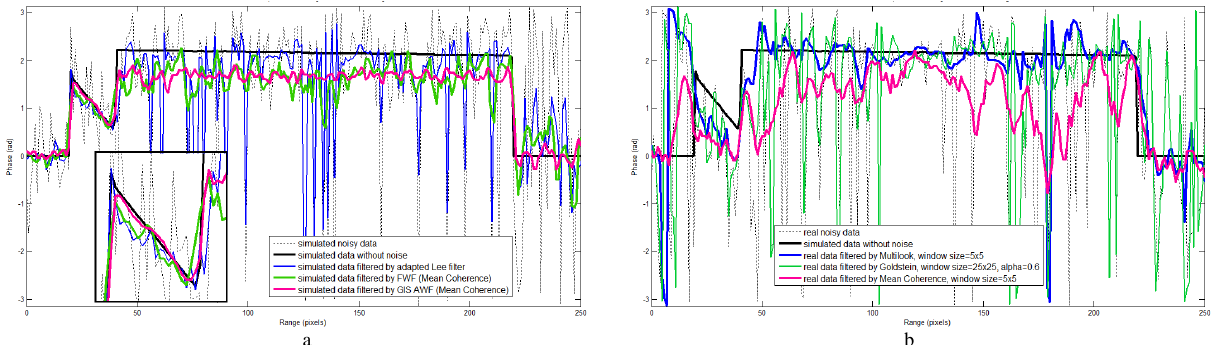
Figure 7. Slant-Range Profiles: a) filtering of noisy simulated phases and b) filtering of real interferometric phases